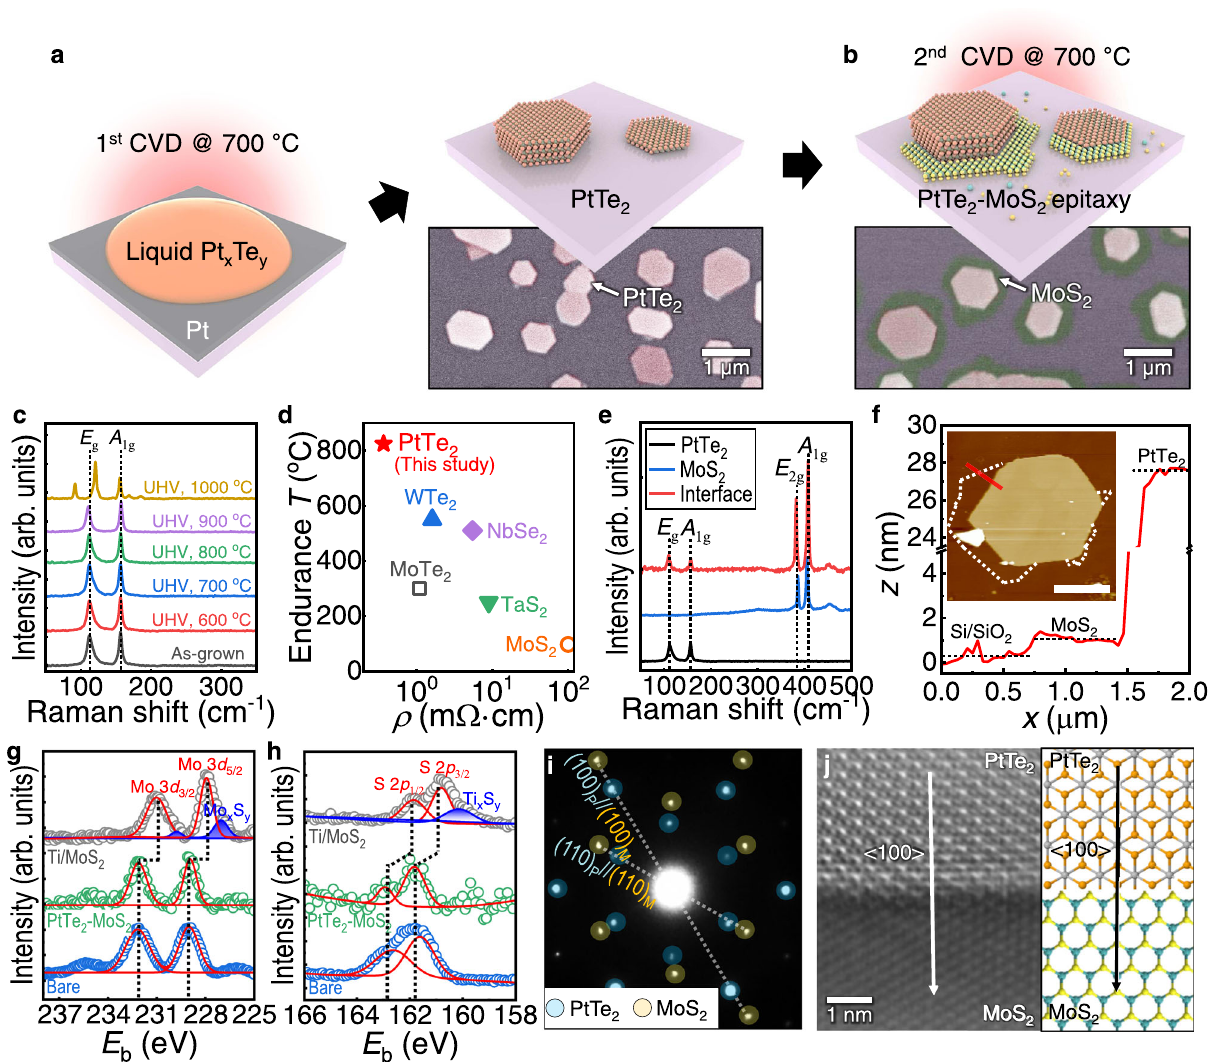
Fig. 1 | Formation of MoS 2 – PtTe 2 lateral heterostructure by two-step growth. a Schematic of the growth process for the PtTe 2 fl akes at a growth temperature of 700°C. b Schematic of the growth process of MoS 2 along the edge of PtTe 2 . The insets of ( a ) and ( b ) show the representative false-colored scanning electron microscopy (SEM) image of the synthesized PtTe 2 fl akes and PtTe 2 -MoS 2 hetero- structures on SiO 2 /Si substrate. c Raman spectra of multilayer PtTe 2 fl akes dis- playing strong E g and A 1g signals (vertical dashed lines) without any substantial differences up to 900°C annealing under UHV conditions. d Benchmark plots of metallic TMDs such as 1T ’ -WTe 2 31,35 , 2H-NbSe 2 32,37 , 1T ’ -MoTe 2 33,38 , 1T-TaS 2 36,39 , and 1T ’ -MoS 2 34 with respect to the room-temperature electrical resistivity ( ρ ) and the endurance temperature, T , that the material can tolerate without structural degradation. The endurance T of the metallic TMDs were characterized under vacuum(solid)orAratmosphere(binned). e ConfocalRamanspectrumcapturedat the heterojunction ’ s interface, PtTe 2 , and MoS 2 fl akes.The verticallinesindicate E g and A 1g modes from PtTe 2 , and E 2g and A 1g modes from MoS 2 . f Atomic force microscopy(AFM)height pro fi lealong the red linedisplayed in the